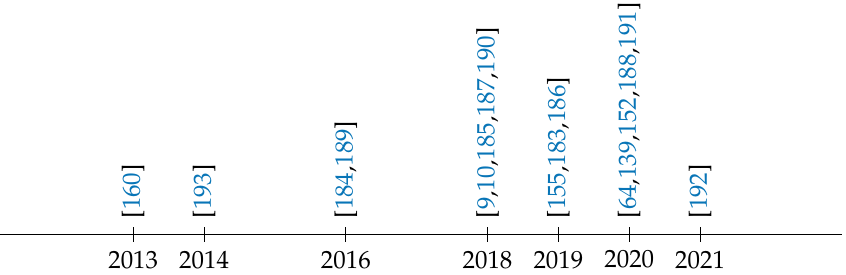
Figure 11. A timeline of different papers within the evaluation of illegal activities over the dark net